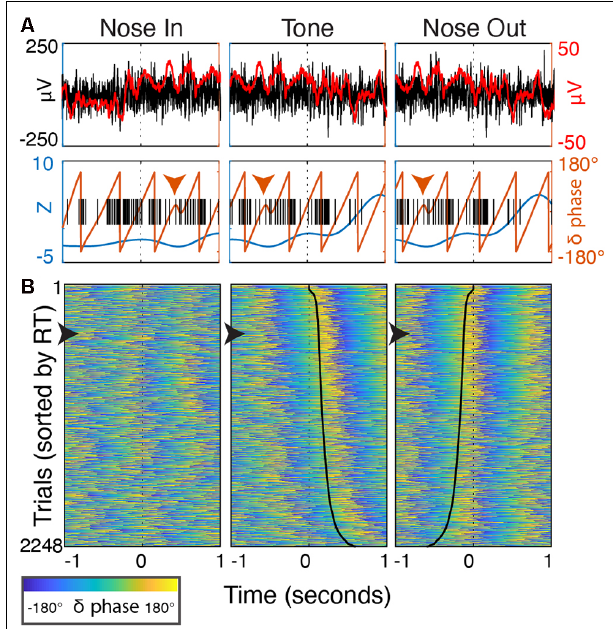
FIGURE 11 | Delta phase evolution through individual trials. (A) Peri-event ( ± 1 s) data from a single trial. Top—the unfiltered, wideband signal (black, left axis) with a 50 ms smoothing filter (red) highlighting discrete delta-band oscillatory patterns after Nose In and before Tone. Bottom—delta power (blue) and phase (orange line, orange arrowhead highlights phase discontinuity), and single-unit spike timing (black). (B) Peri-event delta phase from all trials over 30 sessions ( n = 5 rats) sorted by RT. The trial from (A) is marked with a black arrowhead along the left border. Solid black lines in the Tone and Nose Out panels indicate the Nose Out and Tone events, respectively (i.e., the time from reference event to the black line is